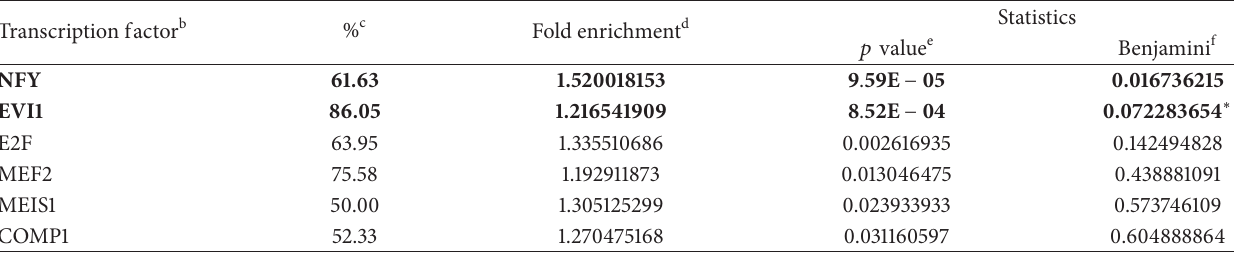
Table 3: Potential transcription factors predicted using DAVID analysis a .